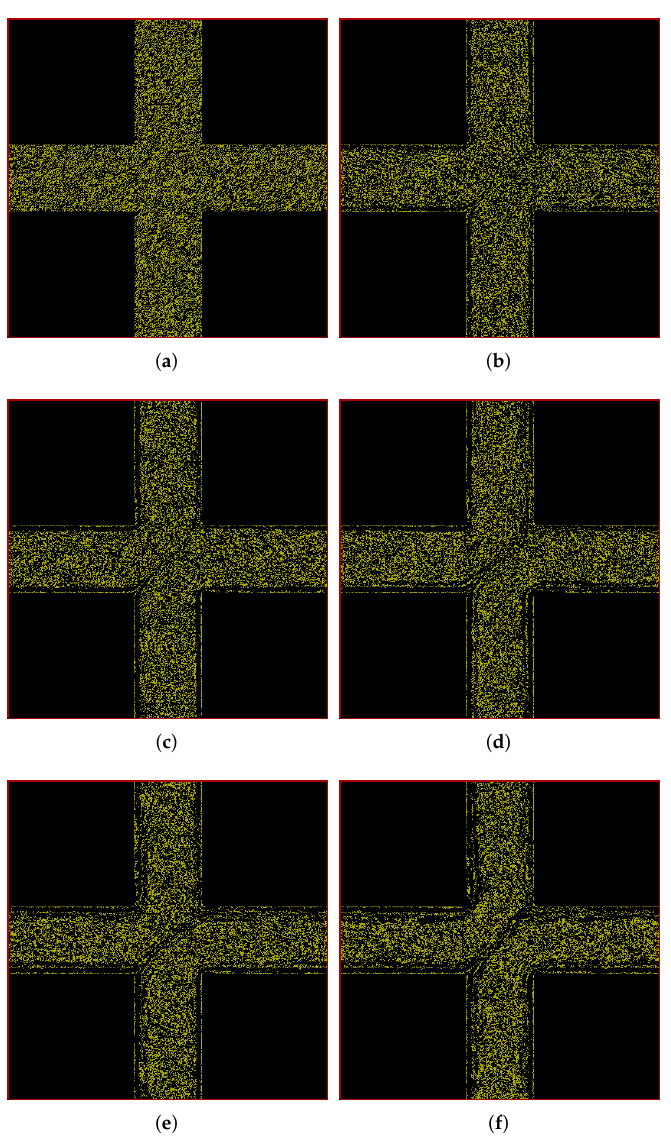
Figure 8. Snapshots of simulation (in porous-media-view) at different times showing development of polymer positions over time for flow through a cuboidal porous medium with pressure applied along the positive x - y diagonal. ( a ) t = 0 s; ( b ) t = 25 s; ( c ) t = 50 s; ( d ) t = 100 s; ( e ) t = 150 s; ( f ) t = 200